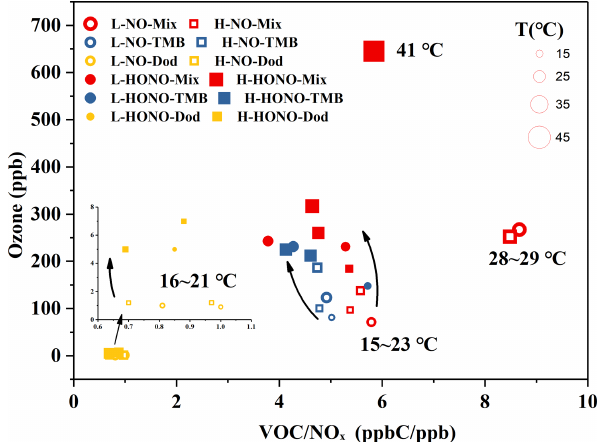
Figure 2. Ozone formation in the NO and HONO experiments. The temperature ( T ) and ozone concentration here refer to the max- imum value during the reaction process. The yellow circles refer to NO-Dod experiments with low SO 2 concentration, and the yel- low boxes refer to NO-Dod experiments with high SO 2 concentra- tion. The yellow filled circles refer to HONO-Dod experiments with low SO 2 concentration, and the yellow filled boxes refer to HONO- Dod experiments with high SO 2 concentration. The blue circles re- fer to NO-TMB experiments with low SO 2 concentration, and the blue boxes refer to NO-TMB experiments with high SO 2 concentra- tion. The blue filled circles refer to HONO-TMB experiments with low SO 2 concentration, and the blue filled boxes refer to HONO- TMB experiments with high SO 2 concentration. The red circles re- fer to NO-Mix experiments with low SO 2 concentration, and the red boxes refer to NO-Mix experiments with high SO 2 concentration. The red filled circles refer to HONO-Mix experiments with low SO 2 concentration, and the red filled boxes refer to HONO-Mix experi- ments with high SO 2